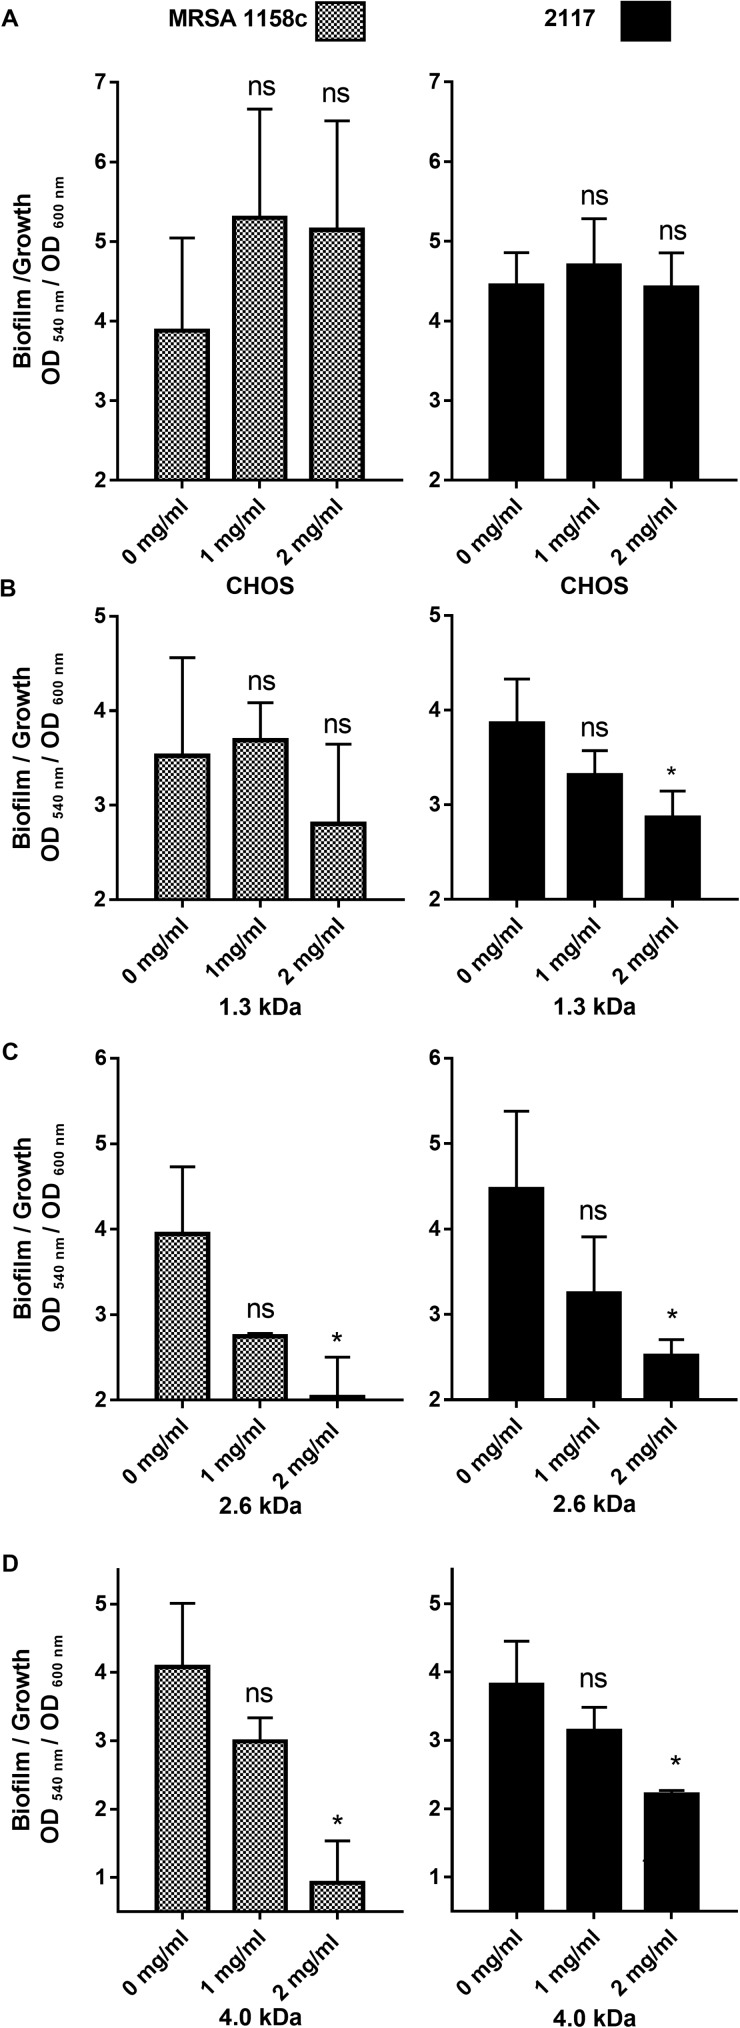
Antibiofilm activity of the different forms of chitosan against MRSA 1158c and the biofilm hyperproducer strain 2117.(A) CHOS, (B) 1.3 kDa, (C) 2.6 kDa, and (D) 4.0 kDa chitosan. Bars represent the means and vertical lines the standard deviation (SD). Data were obtained from three independent experiments. Significant differences in comparison to the untreated control (0 mg/ml) are shown by asterisks. Statistical analysis was performed using Kruskal-Wallis test (non-parametric one way ANOVA) with Dunn’s multiple comparison test: ns, non significant; *, P<0.05.